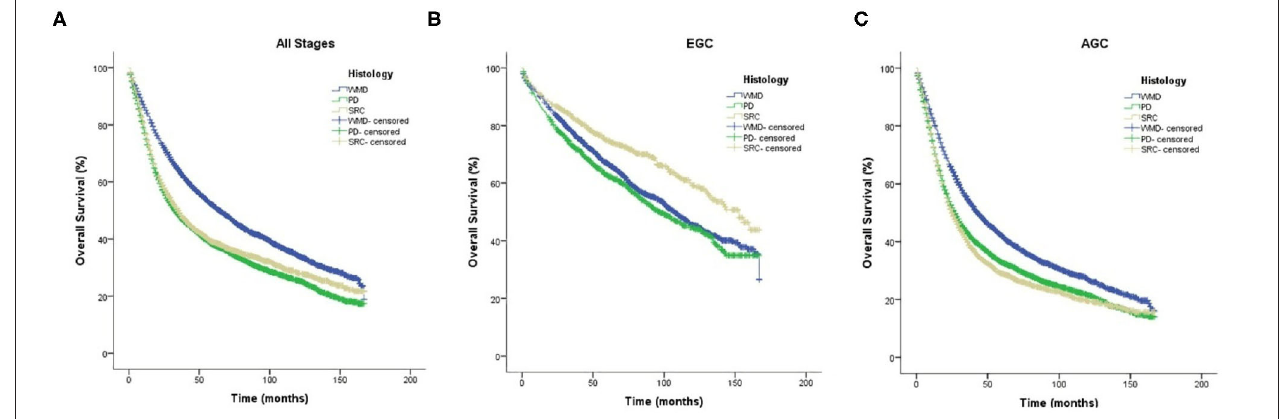
FIGURE 3 | Kaplan–Meier survival curves comparing overall survival in signet-ring cell carcinoma and non-signet-ring cell carcinoma are shown for (A) all stages, (B) early gastric cancer, and (C) advanced gastric cancer.